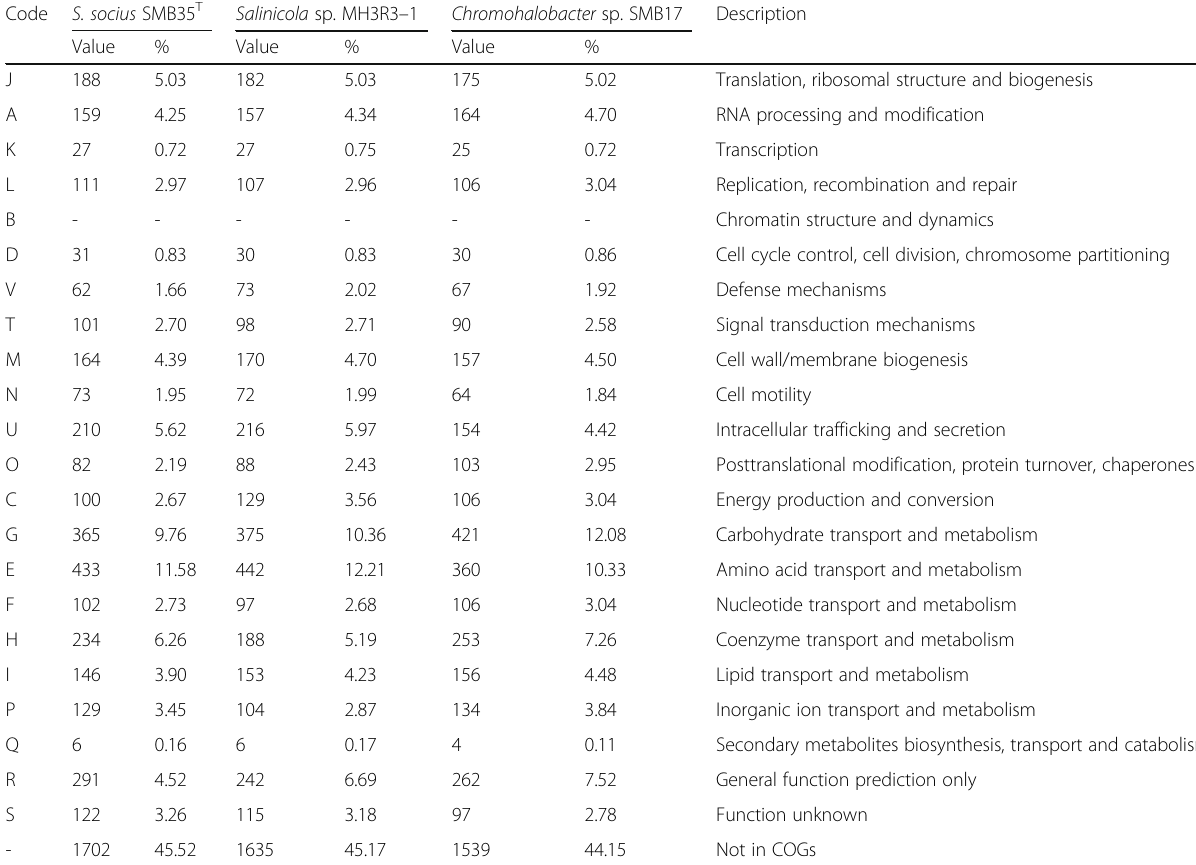
Table 6 Number of genes associated with general COG functional categories Code S. socius SMB35